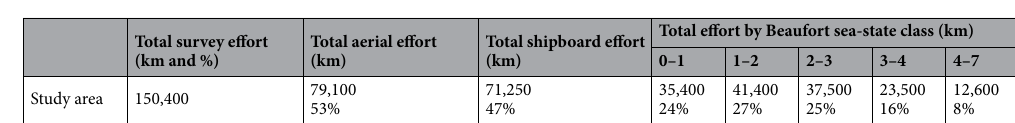
Figure 4. Study area showing assembled survey effort ( a ), along with beaked whale ( b ) and sperm whale ( c ) sightings recorded during all surveys. Surveys were carried out along transects following a line-transect methodology (survey details are provided in Appendix A). Sightings were classified by group sizes with each point representing one group of individuals and point size representing the number of animals in a group. In the analyses, we used the number of individuals to estimate densities of individuals.